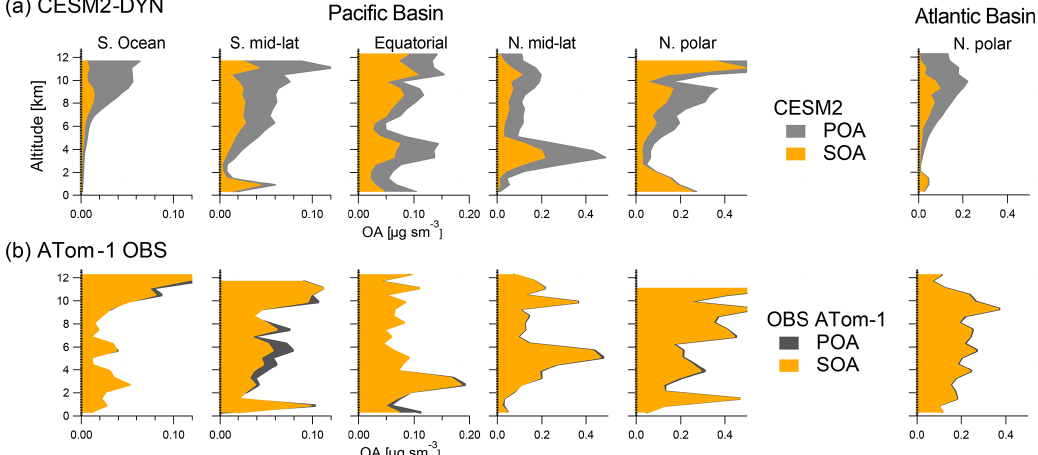
Figure 6. Comparison of averaged POA and SOA vertical profiles as observed during ATom and as predicted by the CESM2-DYN model over the non-BB-influenced Pacific and Atlantic basins. The comparison is not shown for the strongly biomass-burning-influenced regions as all the OA is conservatively allocated to POA in those regions.